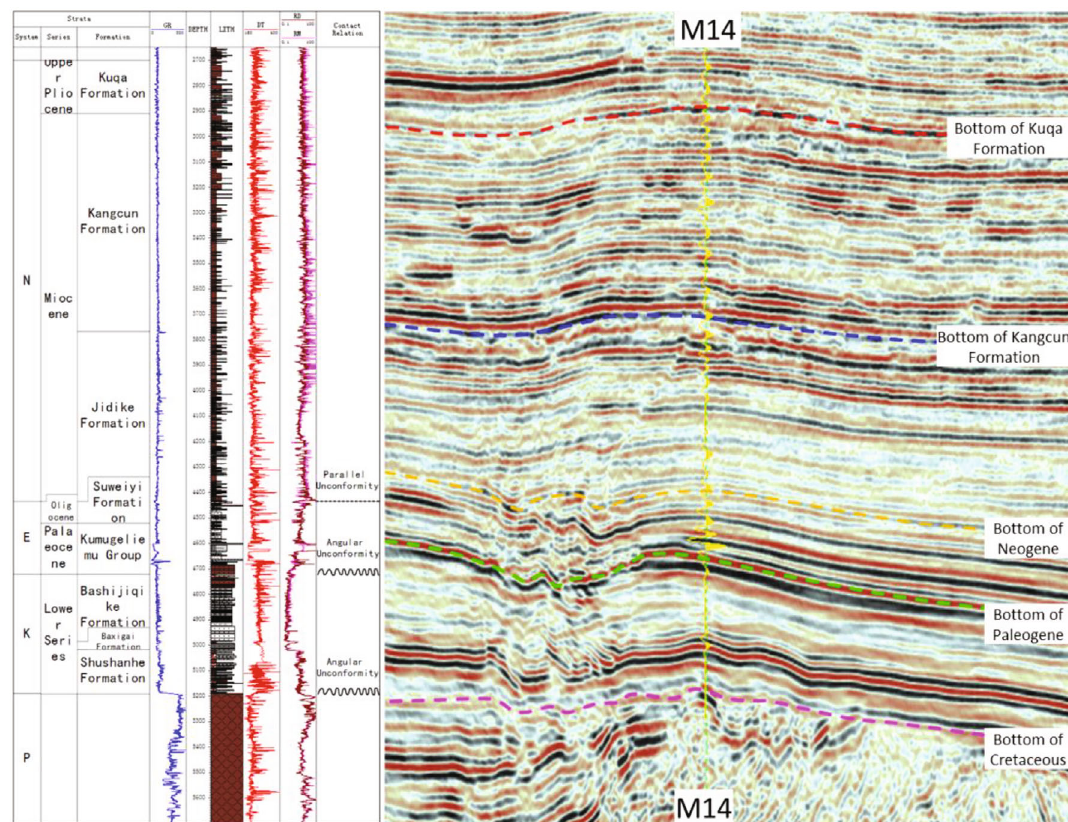
Figure 6: Stratigraphic characteristics of the Cretaceous-Neogene Kuqa Formation.